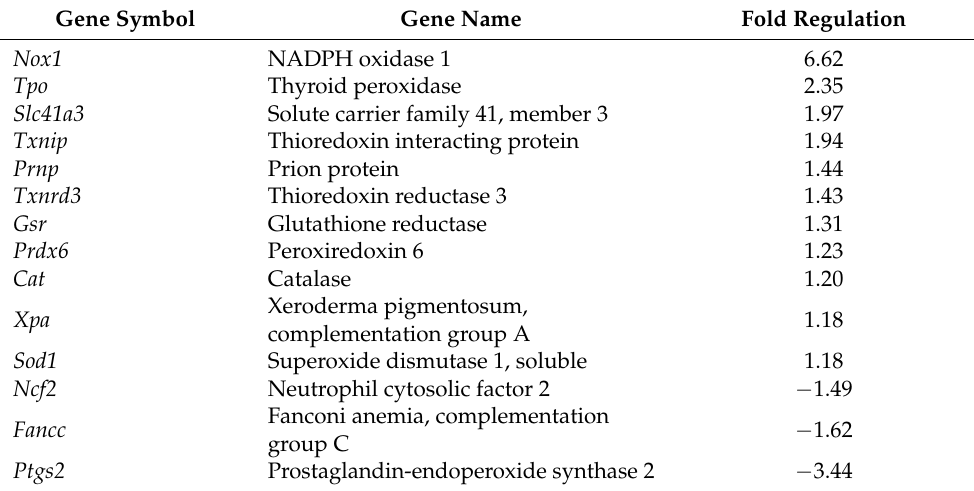
Table 1. Spaceflight altered the expression of genes involved in oxidative stress pathway. Expres- sion levels are represented as fold regulation in spaceflight versus ground controls (FLT versus GRD). Shown are 14 differentially regulated genes out of a panel of 84 genes related to the oxidative stress response as measured by RT-PCR. Of these, 11 were upregulated while three were downreg- ulated. The change in expression levels of these genes were found to be statistically significant by Mann–Whitney U test at p < 0.05, n = 4.